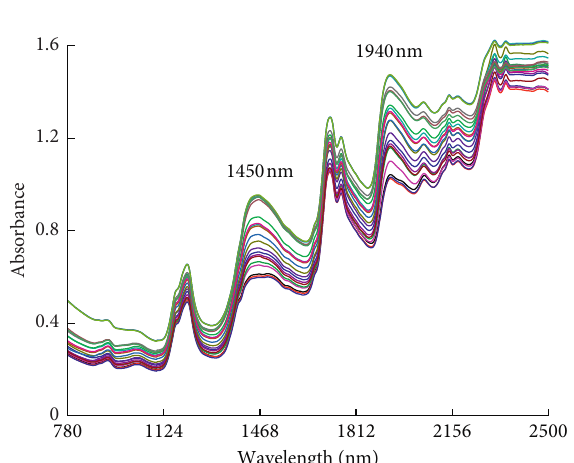
Figure 1: Near-infrared diffuse reflectance spectra of walnut kernel